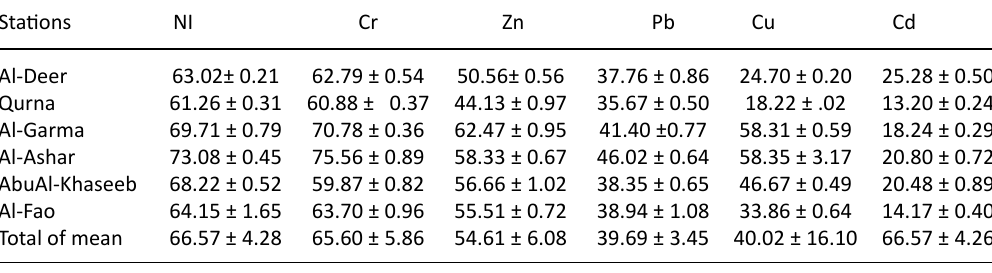
Table 3. The mean Concentration(µg/g) ± SD of Exchangable part of studied metals in the studied stations Stations Ni Cr Al-Deer Qurnah Al-Garma Al-Ashar AbuAl-Khaseeb 54.70 ± 0.79 Al-Fao Total of Mean Table 4. The mean Concentration(µg/g) ± SD of Residual part of studied metals in the studied stations Stations NI